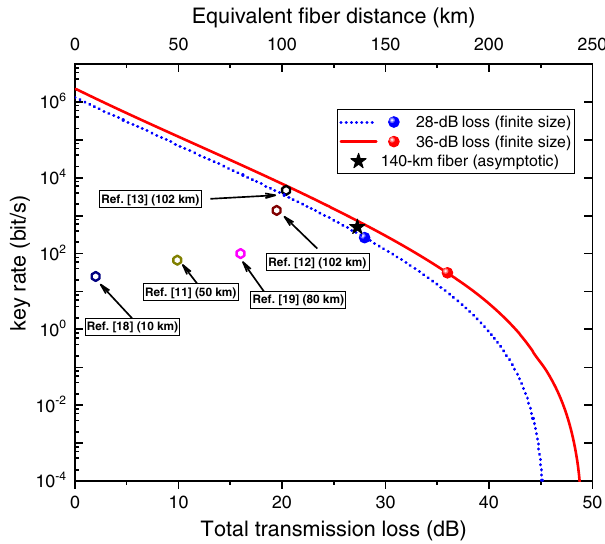
FIG. 4. Secure key rates with different transmission loss. The blue and red points show the experimental results with a total transmission loss of 28 and 36 dB, respectively. The black star is the asymptotic key rate obtained using two 70-km commercial fiber spools. The red solid lines and the blue dot lines are theoretical simulations tailored to the corresponding experi- mental conditions. We also plot the highest finite key rates of current MDI QKD experiments with polarization encoding (navy diamond [18] and black diamond [13]) and time-bin encoding (dark yellow diamond [11], magenta diamond [19], and brown diamond